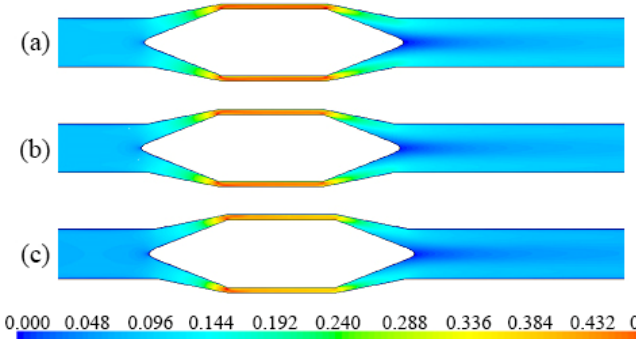
Figure 10. Liquid velocity profile (m / s): ( a ) case #1.1, d = 1 mm; ( b ) case #2.3, d = 1 mm; ( c ) case #3.4, d = 0.91 mm.